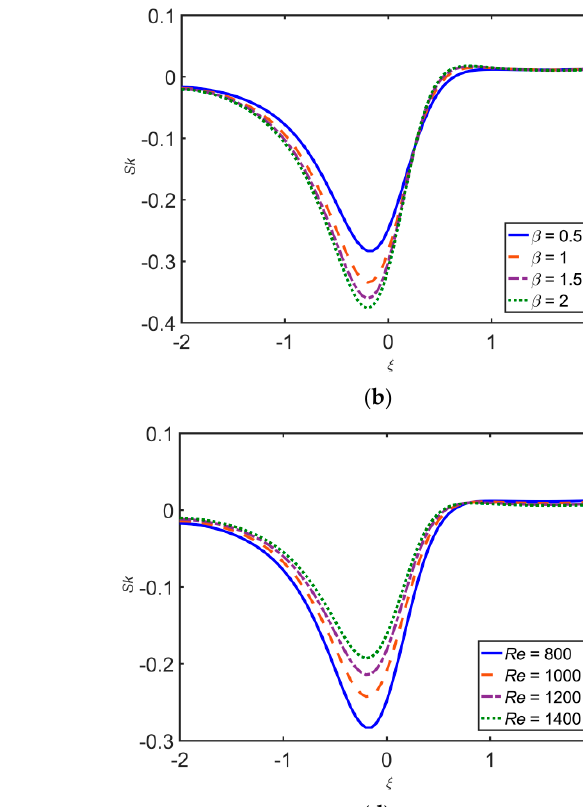
Figure 16. Impact of ( a ) M , ( b ) β , ( c ) D a , and ( d ) Re on Sk . The Nusselt number grows as the flow becomes more turbulent due to the rising number of collisions among the fluid particles. Since more viscous fluids have a lower Reynolds number, less heat transfer occurs, lowering the Nusselt number. The Nusselt number grows as β estimations intensify. The streamlines, vorticity, temperature distribution, and concentration plots with M = 5, St = 0.02, Rd = 0.2, and Re = 800 are shown in Figure 17 for Cu-SWCNT-based HNF. The formation of vertical eddies in the vicinity of the walls can be observed. The eddies increase for the HNF and slowly occupy a major part of the channel downstream of the constriction. The inclusion of multiple types of NPs adds more energy. This results in higher increments in the temperature as well as the thickness of the thermal boundary layer. A rapid rise in the temperature is due to the HNF, since it increases the thermal conductivity. However, the significant impact can be seen in the case of concentration profile.